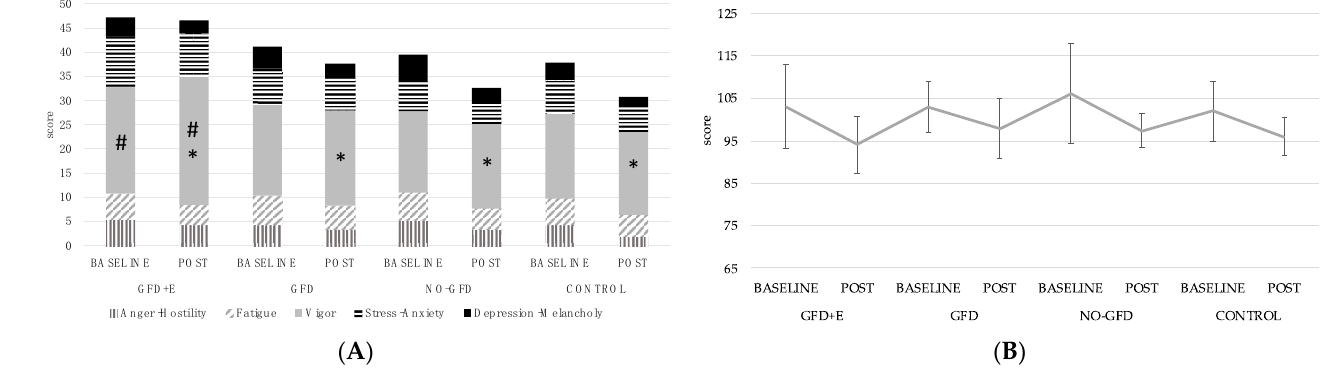
Figure 4 . ( A ) Descriptive statistics of the different subscales of POMS questionnaire in menopausal and postmenopausal women participants; ( B ) descriptive statistics of the POMS total scores. POMS = Profile Of Mood States; * mean differences were significant at p < 0.005; # mean differences were significant at p < 0.001; GFD + E = celiac women with a nutritional plan and physical exercise; GDF, celiac women with a nutritional plan; NO-GFD, celiac women with no nutritional plan or physical exercise; control, healthy women without diet or physical exercise intervention.